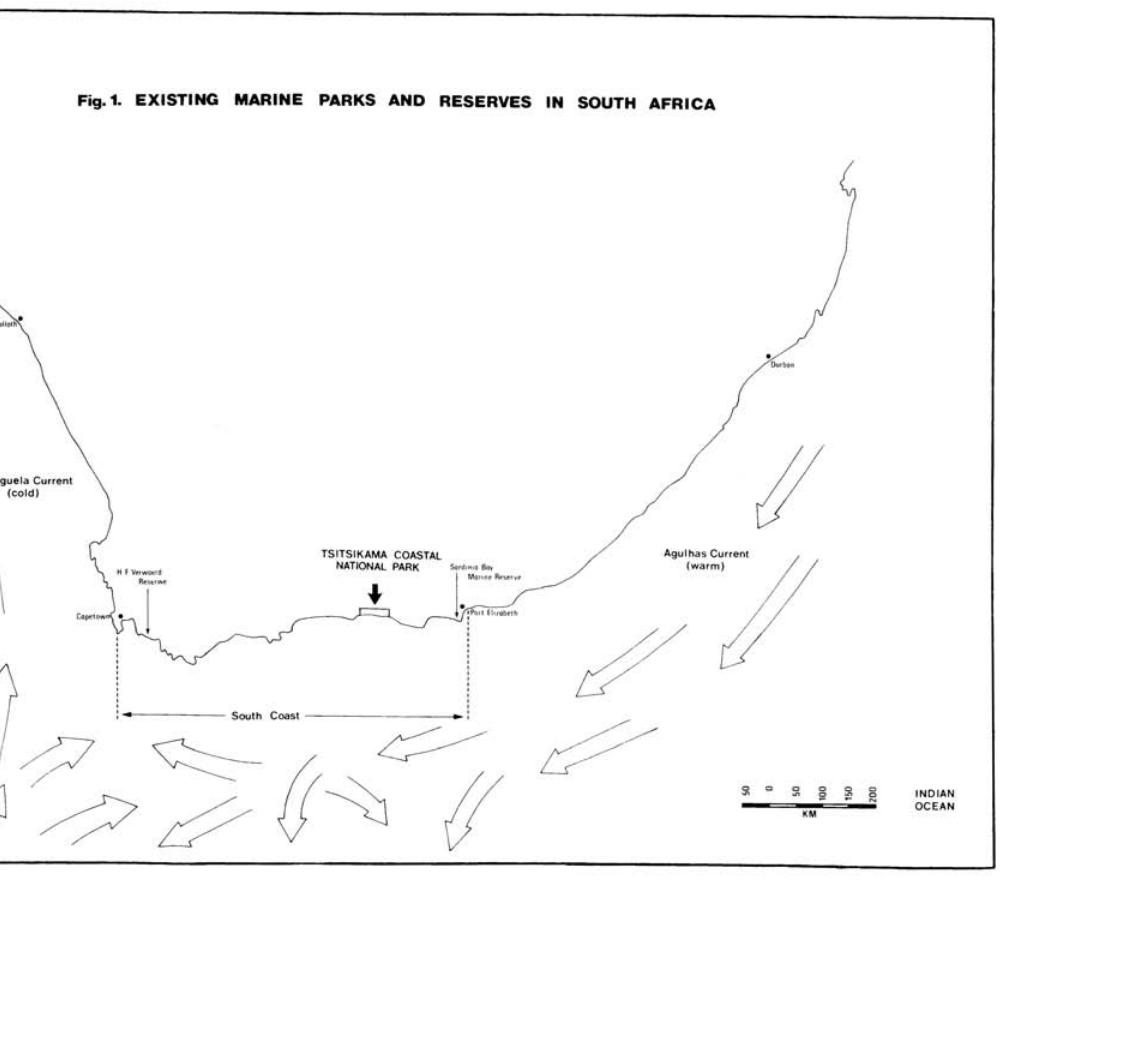
Fig. 1. EXISTING MARINE PARKS AND RESERVES IN SOUTH